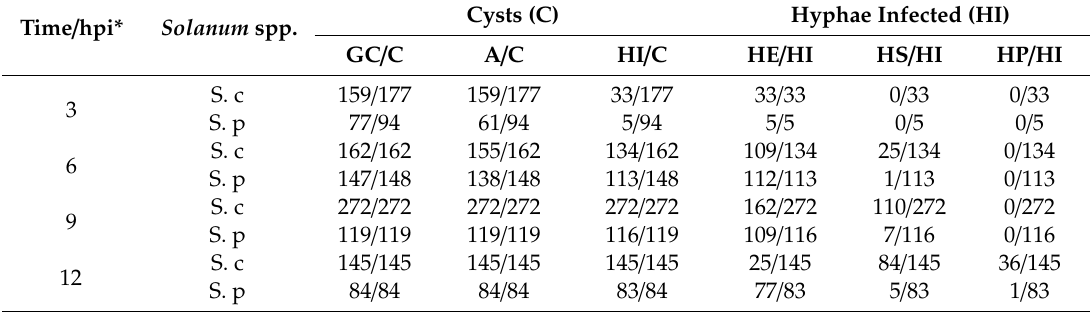
Hpi refers to hours post-inoculation; GC abbreviate for short germinated cysts; A is the abbreviation for appressoria formed by cysts observed; HE is short for hyphae infected in epidermis; HS is short for hyphae infected in